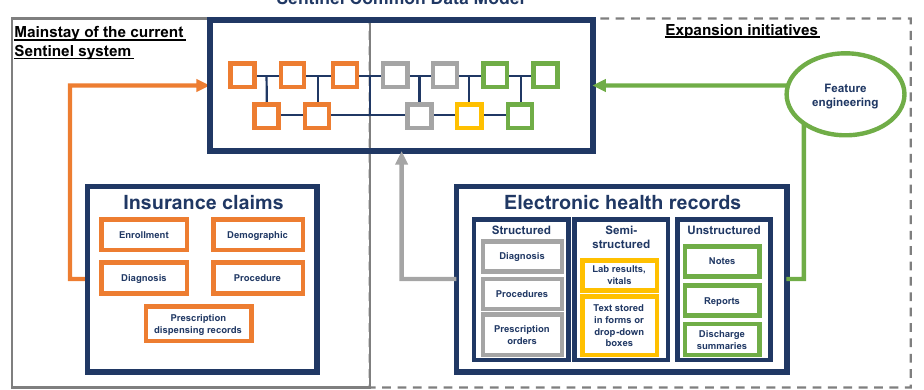
Fig. 1 Conceptual overview of the integration of claims data and electronic health records in Sentinel. Solid box on the left indicates data elements currently available in the Sentinel common data model, dotted box on the right indicates elements from electronic health records that will be considered for